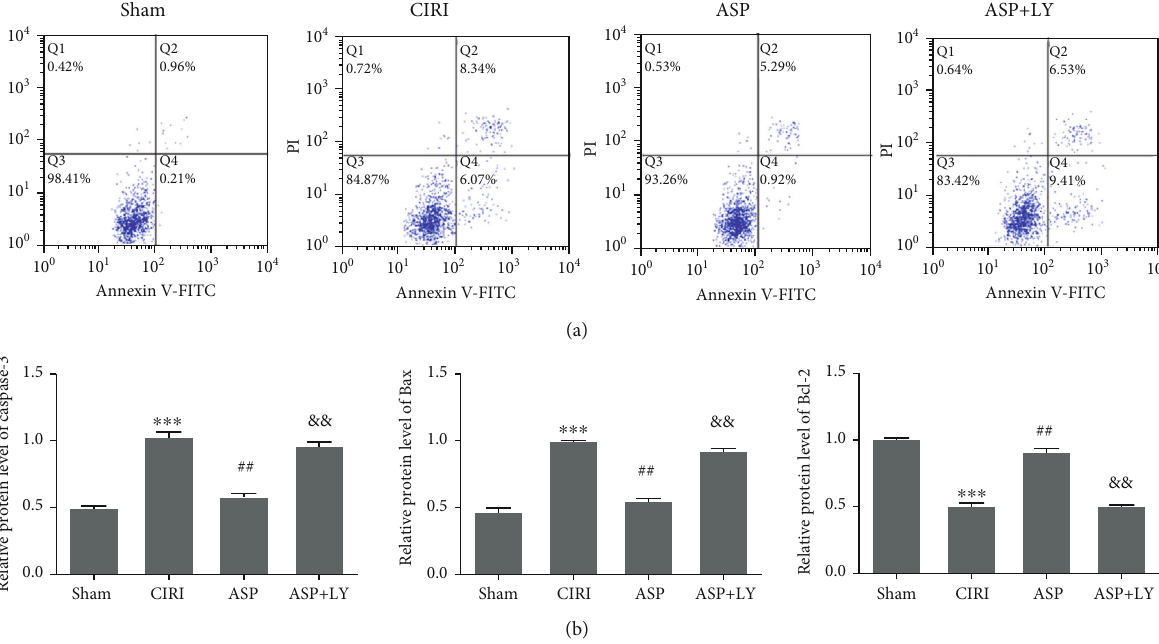
Figure 4: The e ff ect of ASP on cell apoptosis of CIRI rats. (a) Flow cytometry analysis of the apoptosis of nerve cells in the brain tissues of rats in di ff erent groups. (b) Western blotting assay for the apoptosis related-proteins expression of caspase-3, Bax, and Bcl-2. Note: compared with the sham group, ∗∗∗ P < 0 : 001 ; compared with the CIRI group, ## P < 0 : 01 ; compared with the ASP group, && P < 0 : 01 . N = 10 per